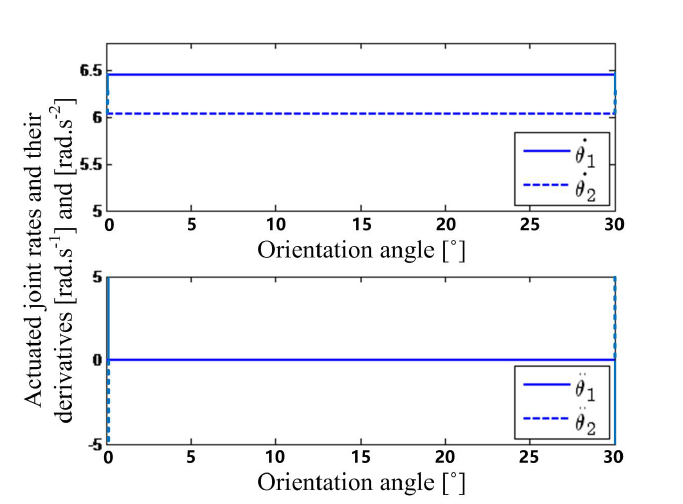
Figure 11. Actuated joint rates and angular accelerations on the circular arc.